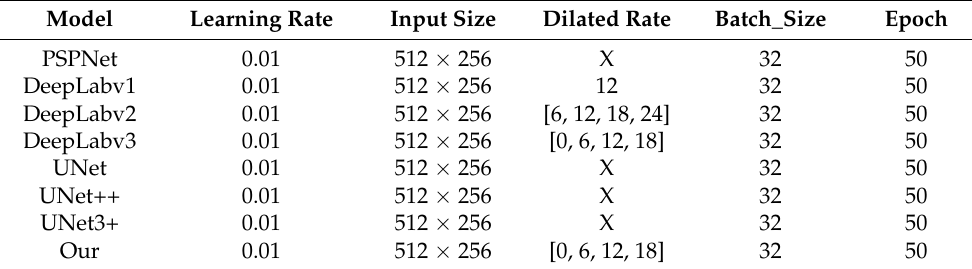
Table 1. Hyperparameters for